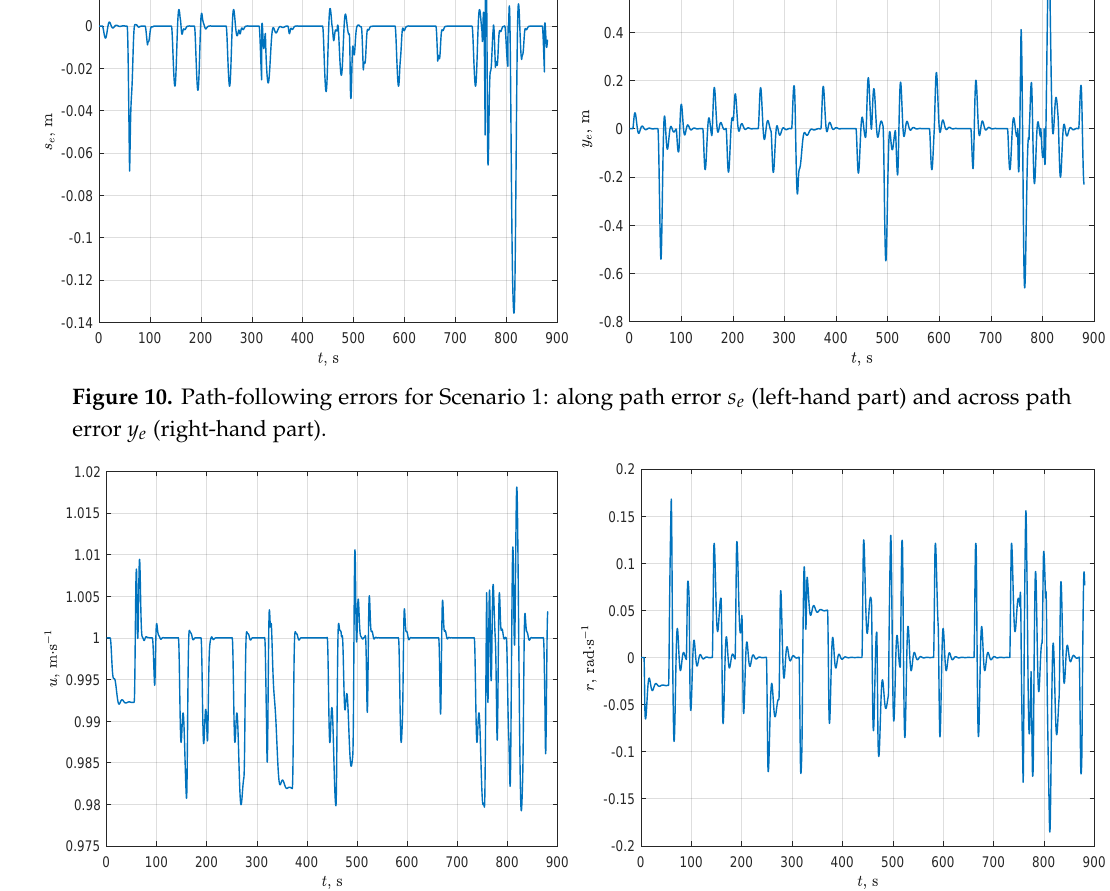
Figure 11. AUV velocities for Scenario 1: forward velocity (left-hand part) and yaw velocity (right-hand part).